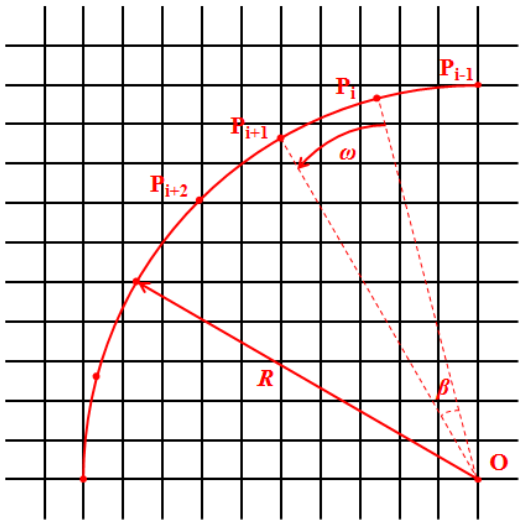
Figure 2. Schematic diagram of minimum angular velocity.